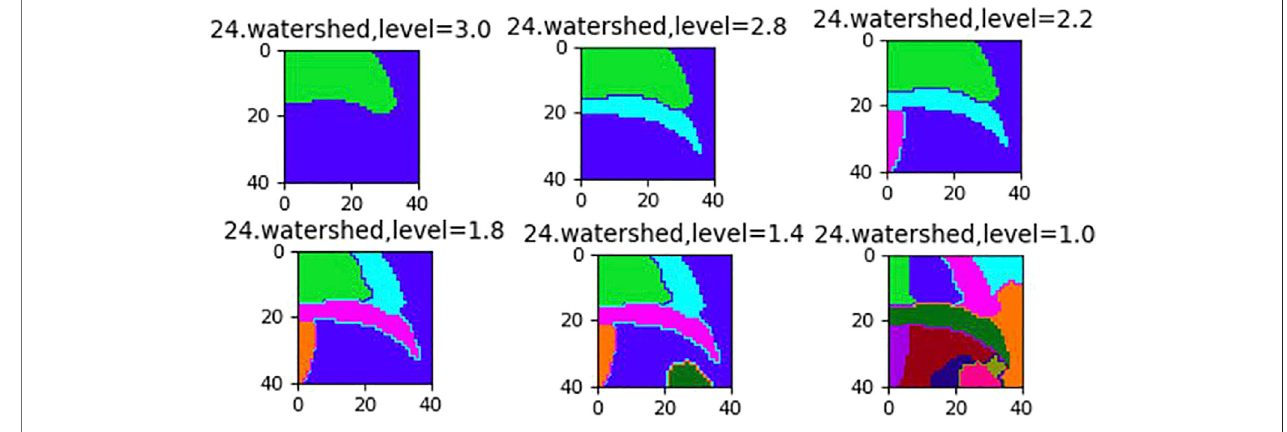
FIGURE 3 | The effect of different segmentation levels.